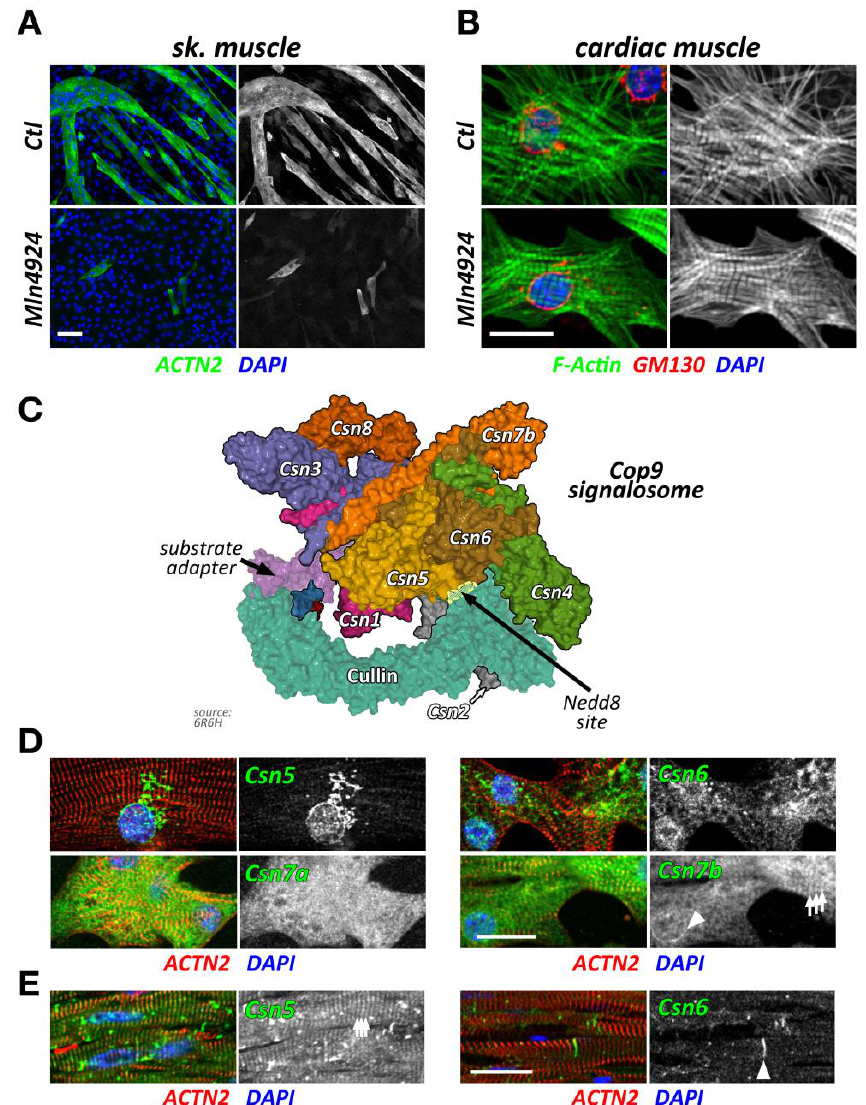
Figure 2. Cullin inhibition and characteristics of the Cop9 signalosome and its subunits. ( A , B ) Effect of cullin inhibition by Mln4924 on differentiating C2C12 cells (sk. muscle) after 5 days (also reported in [ 20] ) ( A ) or neonatal mouse cardiomyocytes (cardiac muscle) after 2 days. C2C12 cells are decorated with antibodies against sarcomeric actinin (Actn2; green) and DAPI (blue). Neonatal mouse cardiomyocytes are stained with antibodies directed against GM130 (red) as well as phalloidin (green) and DAPI (blue). Scale bars = 20 µm. ( C ) Surface representation of the Cop9 signalosome complex (structure 6R6H [30] ) together with cullin-1 bound to Skp1 and an F-box domain-containing substrate adapter. The site of neddylation in cullin is highlighted. The core subunits Csn5 and Csn6 are in close proximity to the neddylation site, while adjacent subunits Csn2 and Csn4 act as a clamp to correctly position the Rbx1 bound cullin protein for the deneddylation process. ( D , E ) Immunofluorescence analysis of Cop9 subunit localization in neonatal mouse cardiomyocytes ( D ) and adult mouse heart tissue ( E ). Core subunits Csn5 and Csn6 display localization to the endoplasmic reticulum or a diffuse localization in neonatal mouse cardiomyocytes ( D upper panels), while they localize to the region of the Z-disk and intercalated disk in adult heart tissue ( E ; arrowhead denotes intercalated disk). Other peripheral Cop9 subunits, such as Csn7a or Csn7b also show divergent localization ( D lower panels), displaying either diffuse (Csn7a), or perinuclear (arrowhead) and Z-disk-associated (arrows) targeting (Csn7b). Sarcomeric actinin (Actn2, in red) and DAPI (in blue) were used as counterstains. Scale bars = 20 µm.